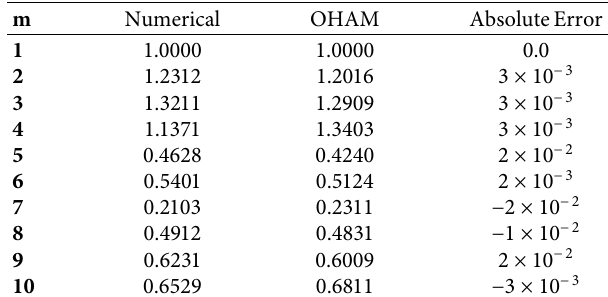
Table 7: Comparison table of analytical method and numerical method for velocity equation.